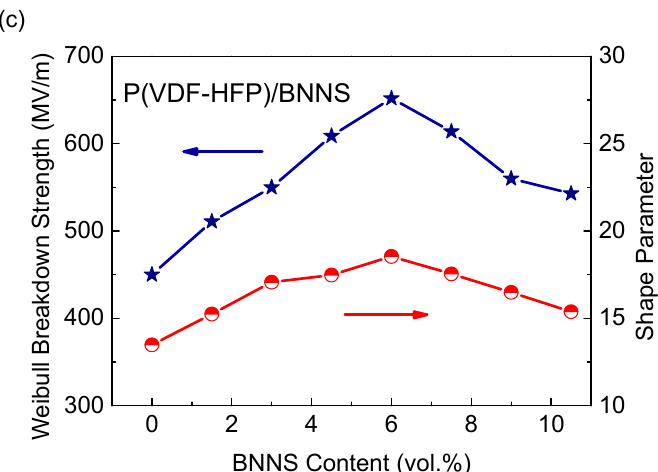
Figure 5. ( a ) Leakage current density of P(VDF-HFP), P(VDF-HFP)/BT, and P(VDF-HFP)/BNNS/BT nanocomposites under the electric field of 100 MV/m. The characteristic breakdown strength and shape parameter of ( b ) P(VDF-HFP)/BT and P(VDF-HFP)/BNNS/BT nanocomposites as a function of BT content and ( c ) P(VDF-HFP)/BNNS nanocomposites as a function of BNNS content.